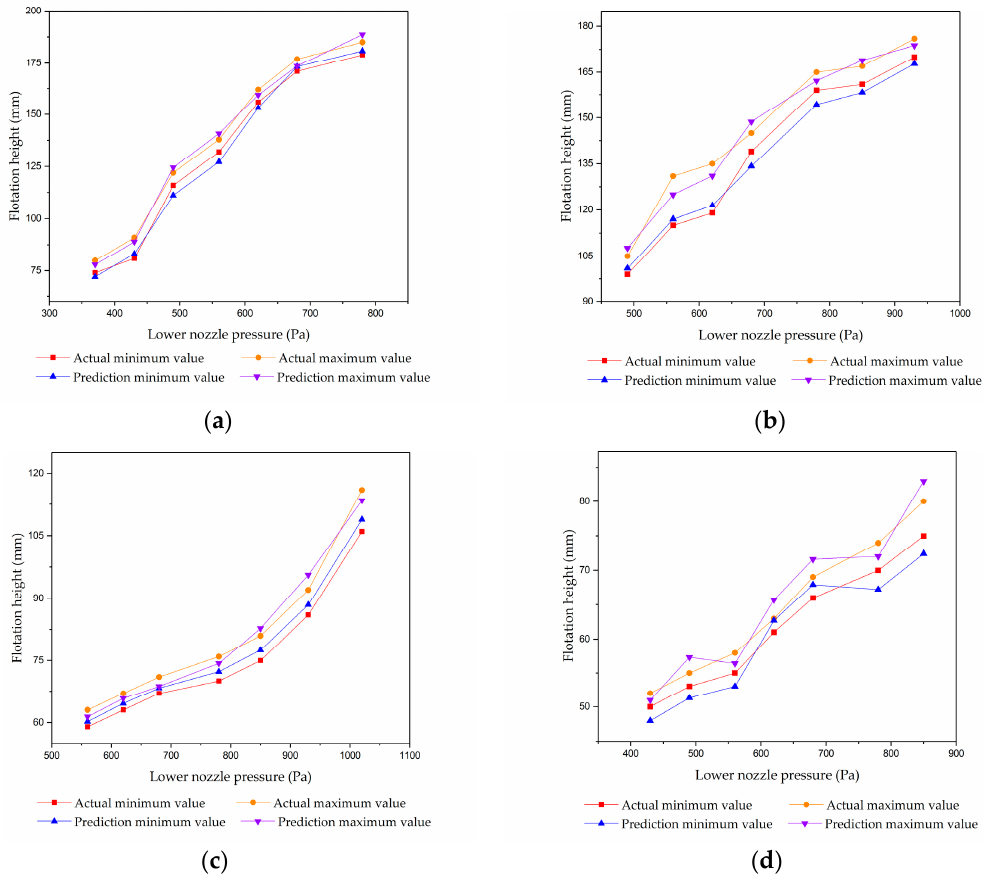
Figure 10. The maximum and minimum floating height at vibration state: ( a ) thickness = 1.5 mm, upper pressure = 40 Pa; ( b ) thickness = 1.5 mm, upper pressure = 90 Pa; ( c ) thickness = 2 mm, upper pressure = 40 Pa; and ( d ) thickness = 2 mm, upper pressure = 90 Pa. Table 1. Root mean square error (RMSE) values of different algorithms in the stable state.